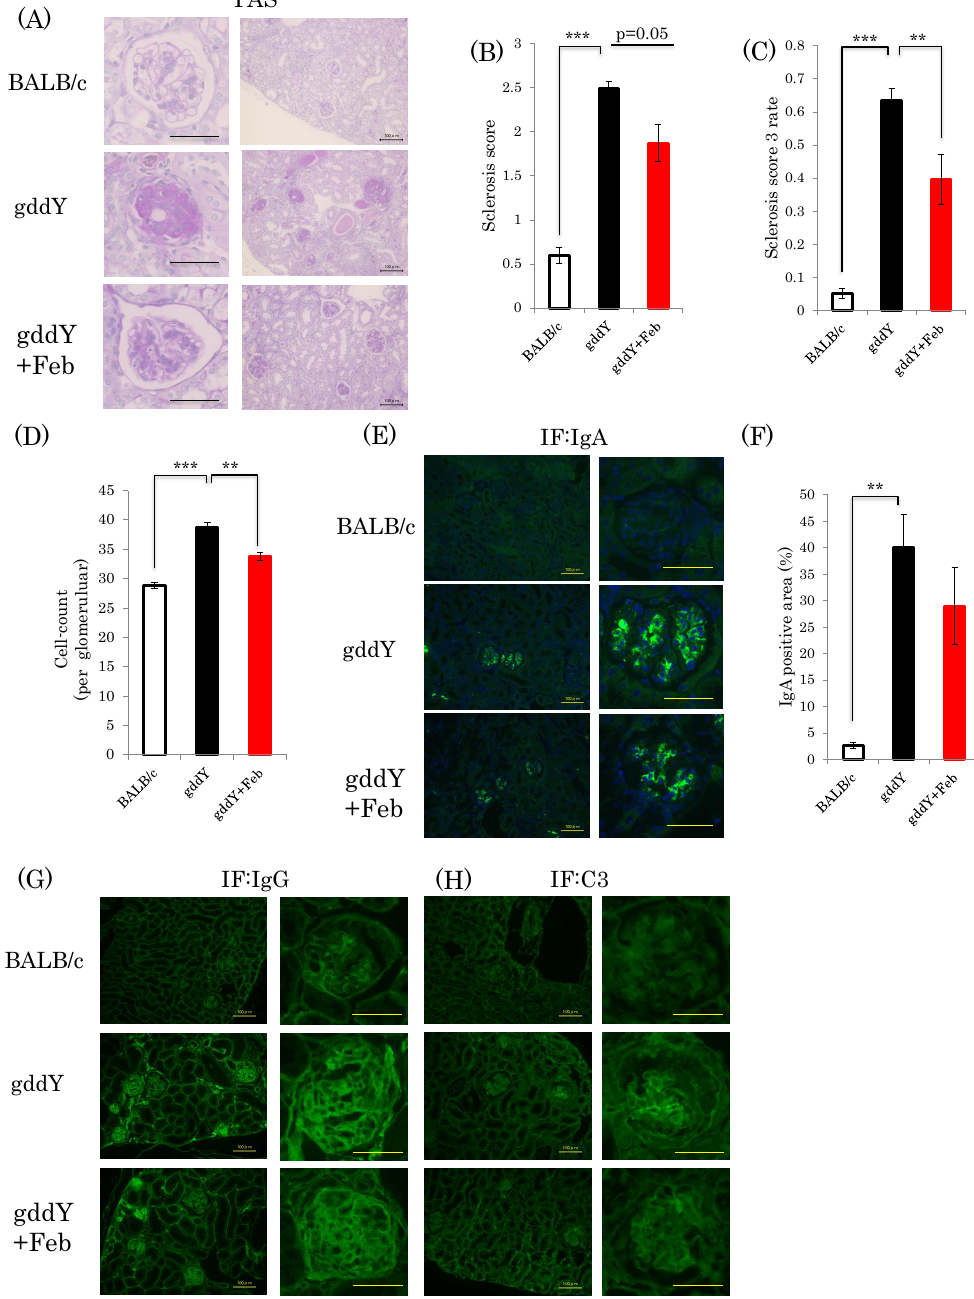
Figure 2. Febuxostat suppresses the development of nephropathy with no significant effects on glomerular IgA deposition. ( A ) PAS staining of kidney fractions. scale bar = 50 µ m (left panel), 100 µ m (right panel); ( B ) Sclerosis scores were calculated. ( C ) Rate of sclerosis score 3 in glomerular specimens; ( D ) Glomerular cell count; ( E ) Immunostaining of renal sections with anti-IgA antibody. scale bar = 100 µ m (left panel), 50 µ m (right panel); ( F ) IgA positive areas in mesangial cells were measured; ( G,H ) Immunostaining of renal sections with anti-IgG antibody or anti-C3 antibody, scale bar = 100 µ m (left panel), 50 µ m (right panel). (BALB/c control mice: n = 8, untreated gddY mice: n = 4, febuxostat treated gddY mice: n = 8) **: p < 0.01, ***: p <